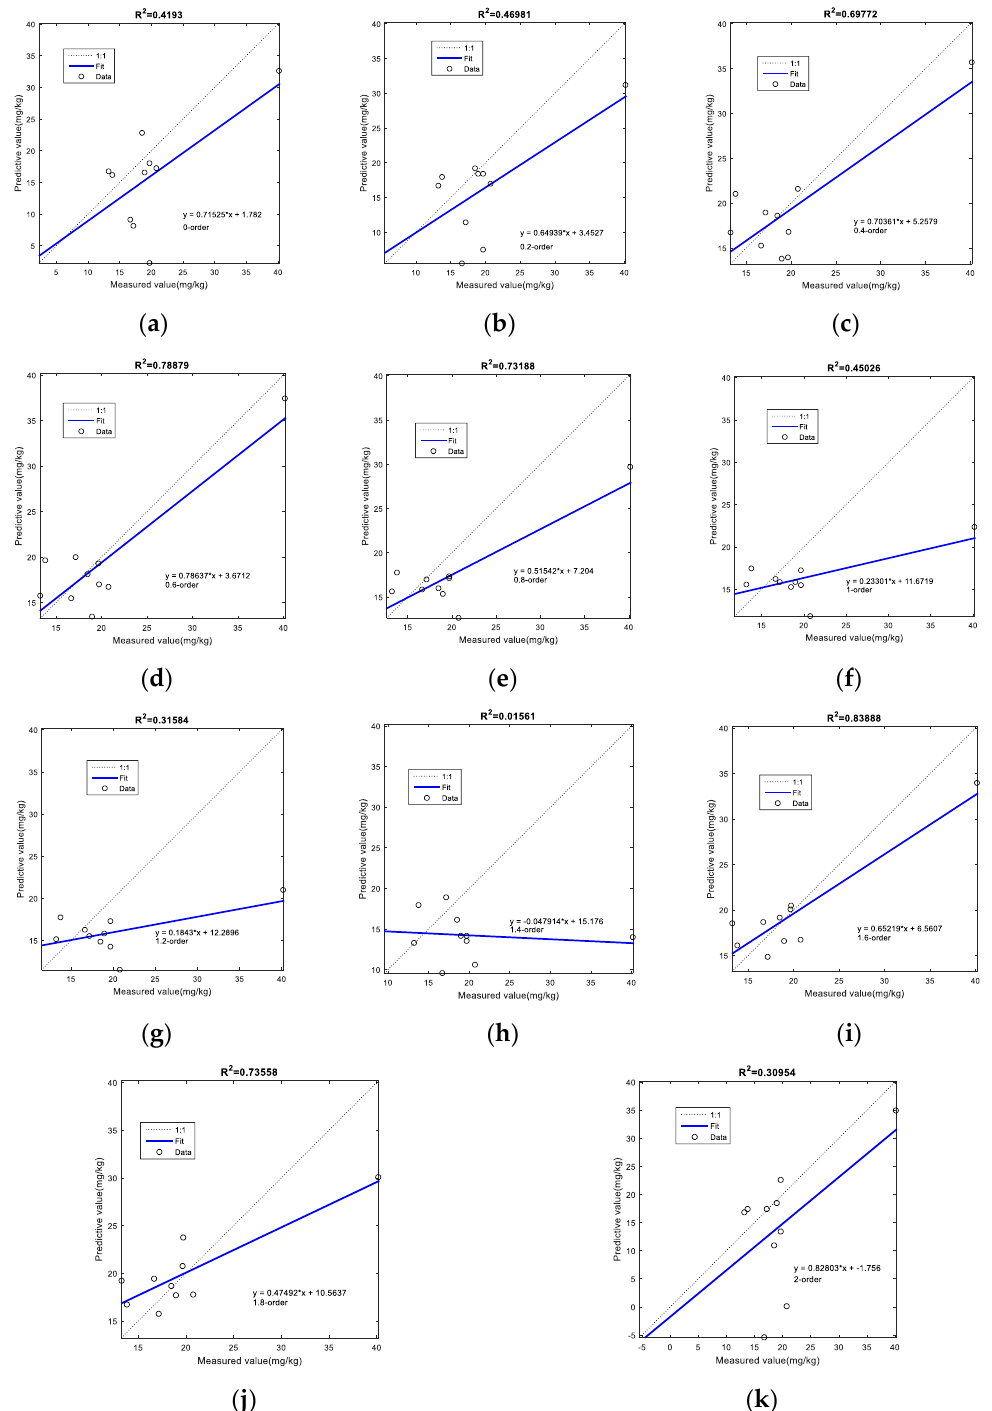
Figure 4. Measured values versus predicted values for verification set: ( a ) 0th-order; ( b ) 0.2-order; ( c ) 0.4-order; ( d ) 0.6-order; ( e ) 0.8-order; ( f ) 1st-order; ( g ) 1.2-order; ( h ) 1.4-order; ( i ) 1.6-order; ( j ) 1.8-order; ( k ) 2nd-order.